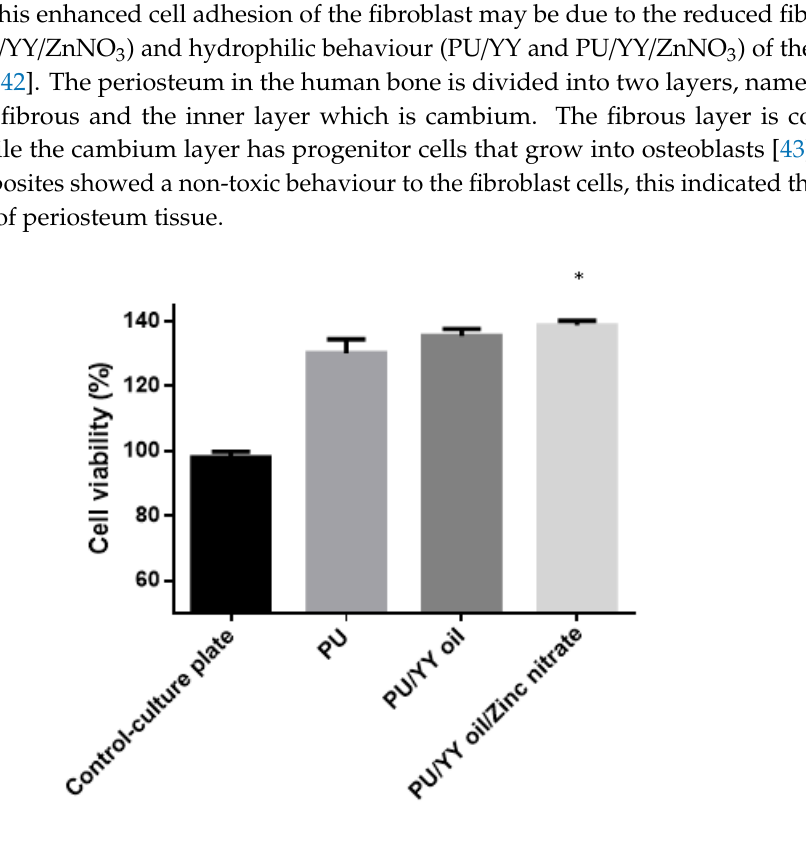
Figure 13. Cell viability of PU, PU/YY and PU/YY/ZnNO 3.